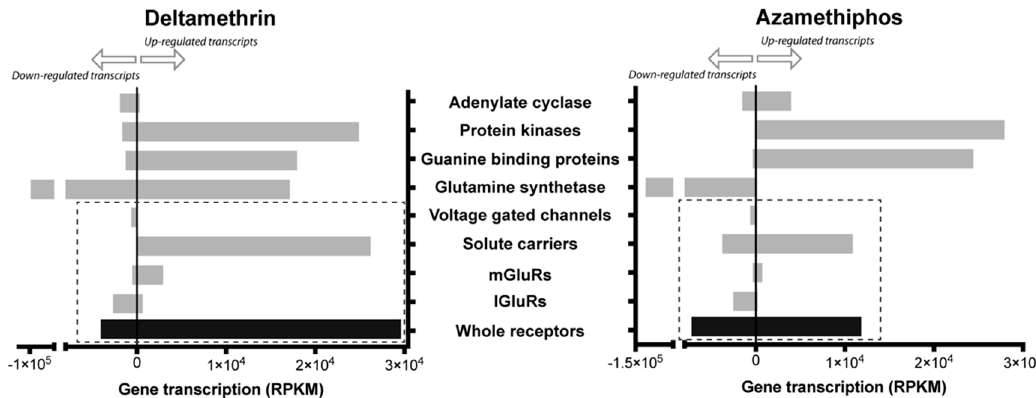
Figure 3. Expression levels of glutamatergic synapse-related genes grouped by molecular functions. Gene expression was measured as the sum of total RPKM after exposure to antiparasitic drugs as compared to control samples. Gray bars correspond to group of contigs clustered by gene family; black bar corresponds to the sum of all the groups that are related to receptors gene families. Dotted rectangle includes the gene families related to membrane receptors.